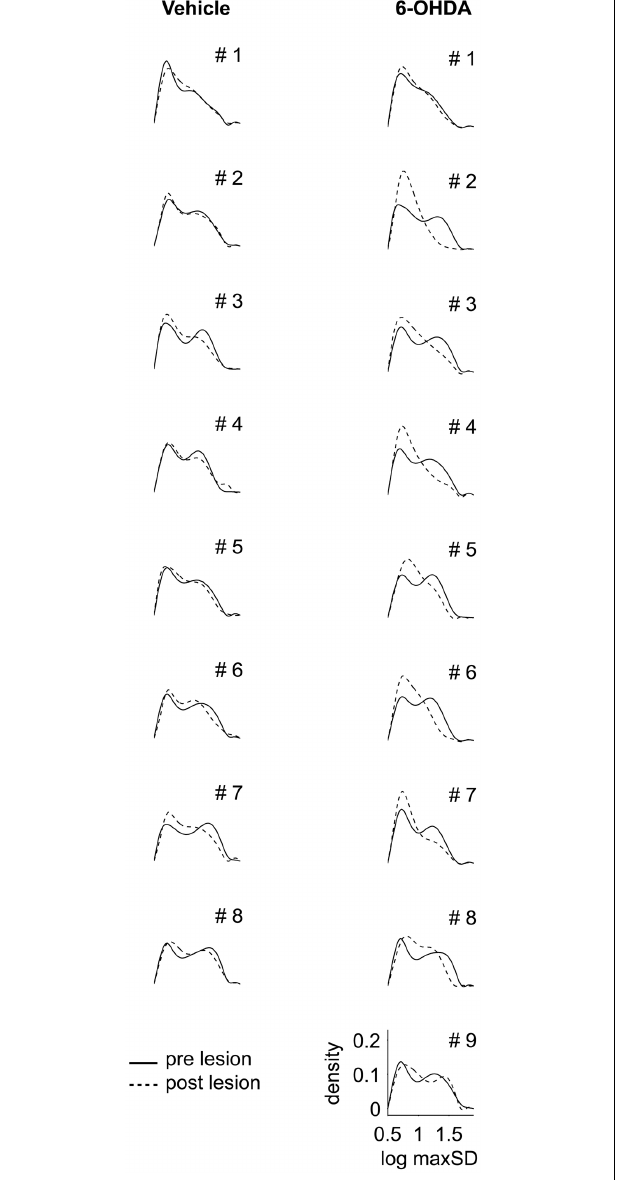
FIGURE 4 | Distribution of maximal speed values. Density functions for logarithmic values of maximal speeds (log max-SD) are shown for all control (left column) and all 6-OHDA lesioned rats (right column). Solid and dashed lines denote log max-SD distributions before and after lesioning, respectively. Animal numbers are given in the right top corner. log max-SD, base 10 logarithm of maximal speed in given movement episode; 6-OHDA,